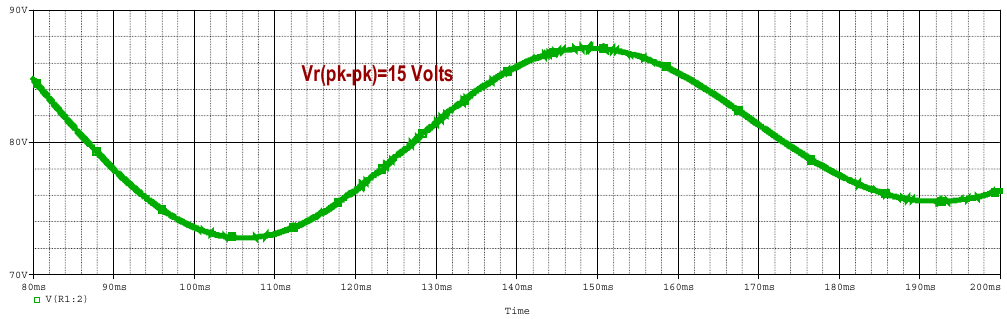
Figure 24. Magnitude of output current ripples for conventional boost converter [28].